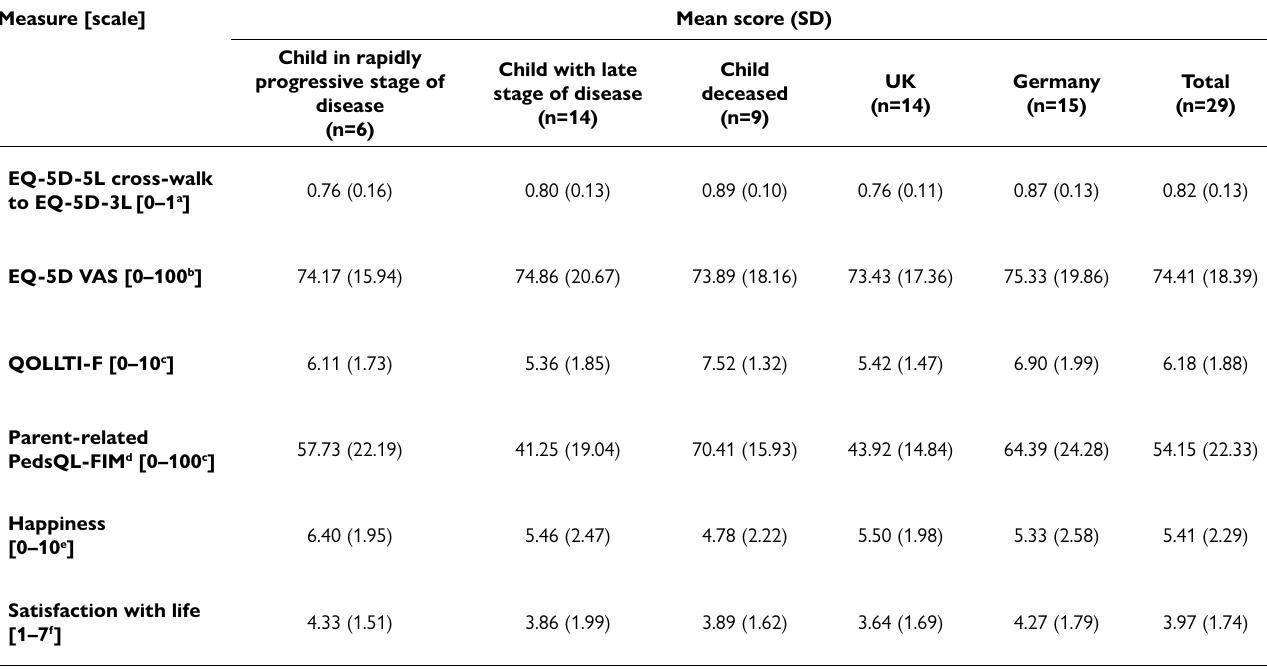
Table 6. Impact of disease stage and country on quality of life measures (excludes adult siblings) Measure [scale] Mean score (SD) Child in rapidly progressive stage of disease